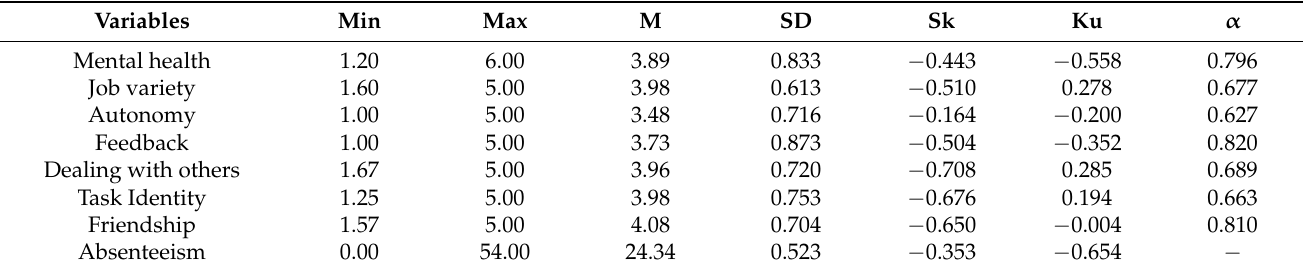
Table 3. Descriptive statistics and the reliability of scale